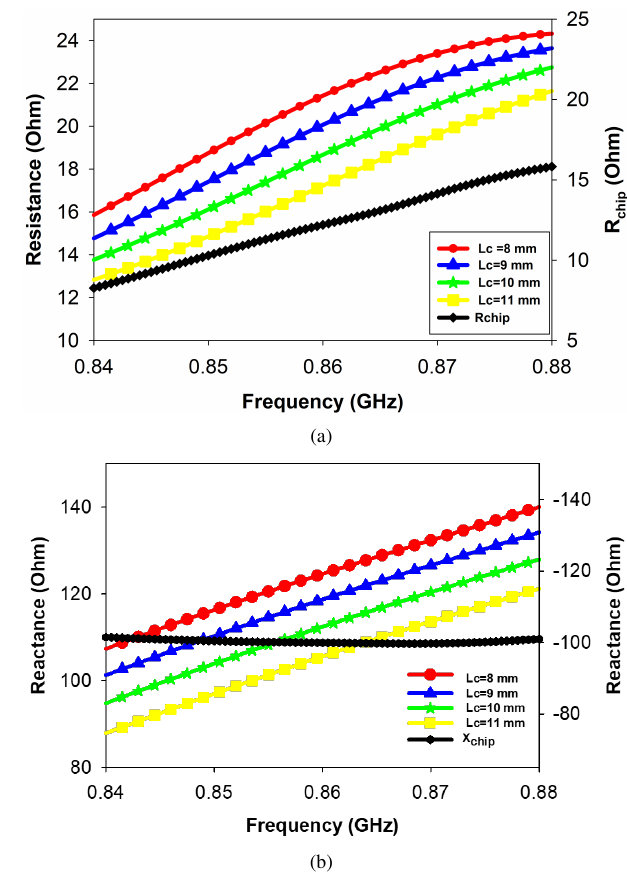
FIGURE 4: Simulated input impedance of the proposed RFID tag antenna for different length LC of the tuning patch at the European